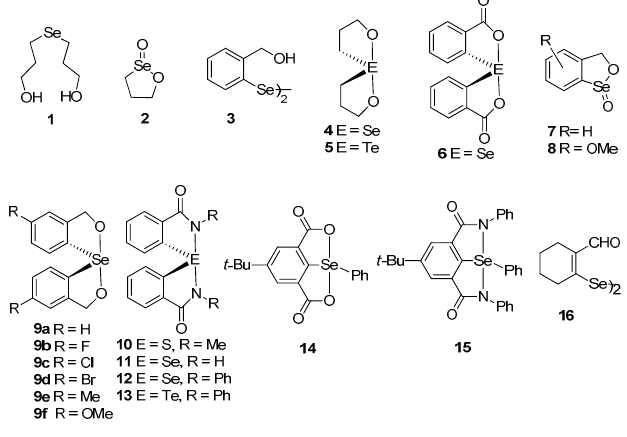
Figure 1. Some GPx